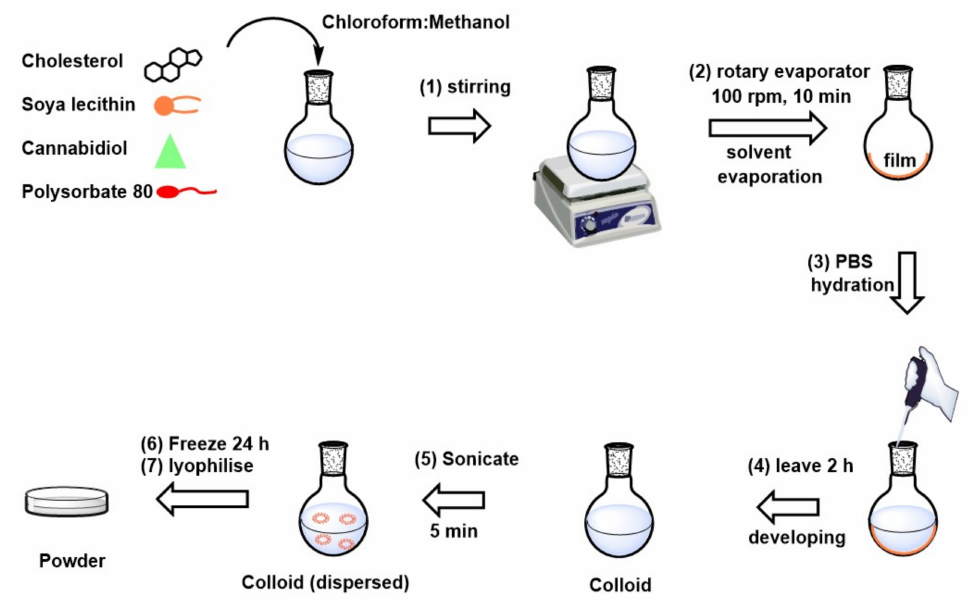
Figure 1. Schematic representation of methodology employed for the preparation of CBD- loaded transfersomes. Table 1. Composition of lipids and solvents used for the formulation of CBD-loaded transfersomes. Formulation